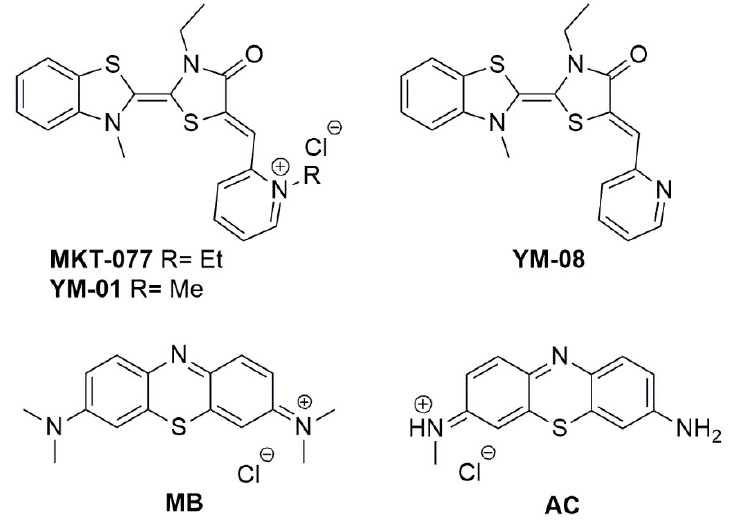
Figure 5. Chemical structures of Hsp70 inhibitors targeting the ATP binding site.